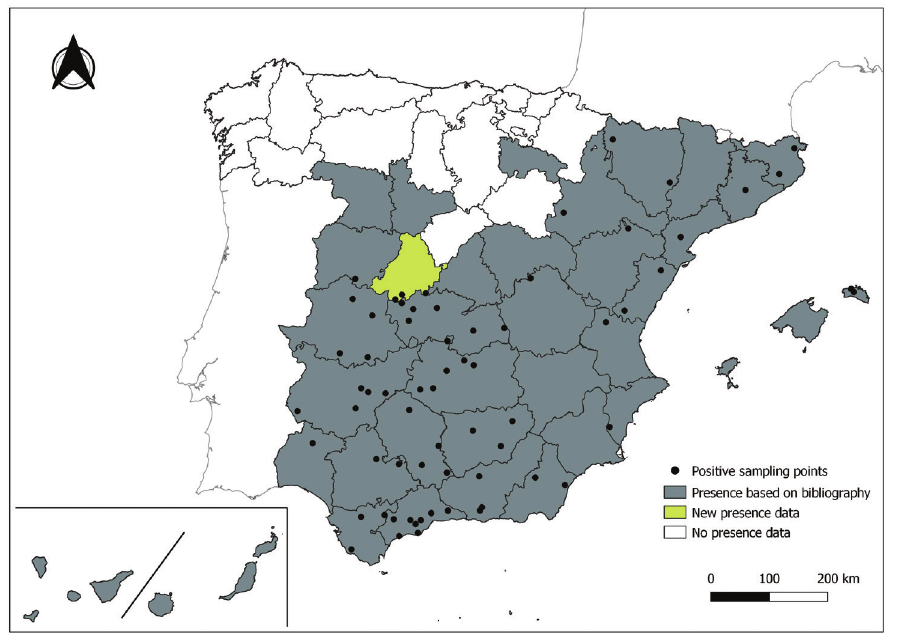
Figure 4. Distribution of Phlebotomus sergenti in